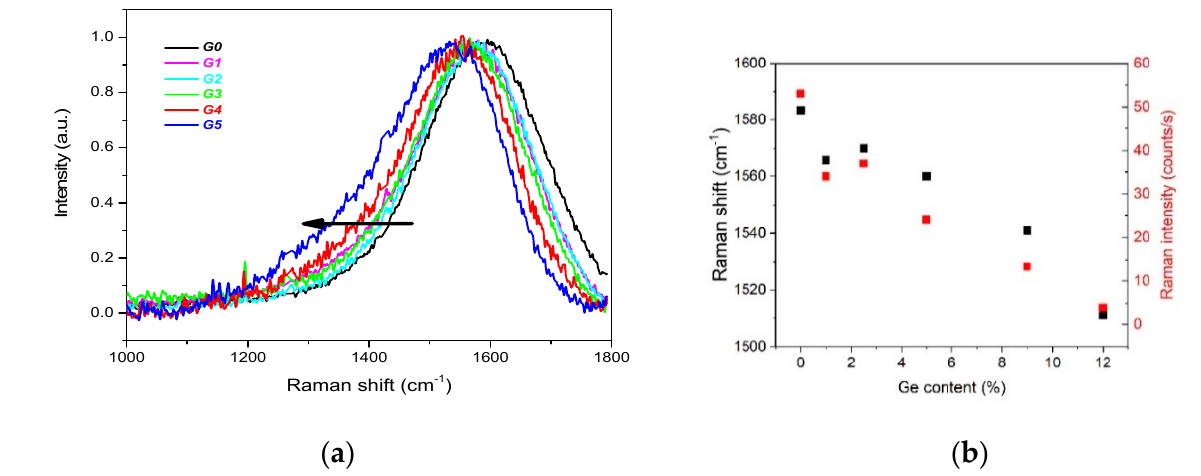
Figure 5. Raman spectra of the analysed samples. The arrow indicates increasing Ge content in DLC:Ge layers ( a ). Changes in the G band position and the Raman signal intensity ( b ) are illustrated.